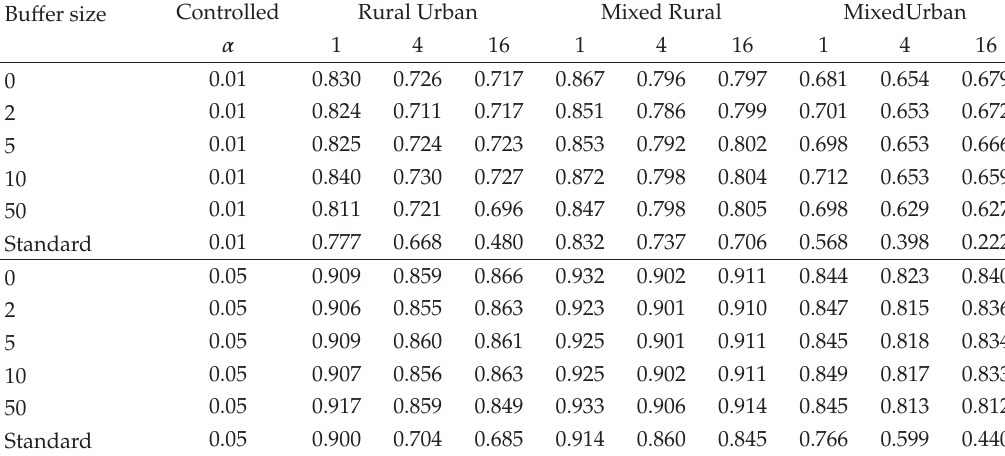
Table 4: Comparison of power to test the second most likely cluster for significance levels 0.01 and 0.05 when two true clusters exist and the tests are the bu ff er removing method and the standard scan statistic method. For the standard method, power is based on the critical values under the the null hypothesis that there are no true clusters. The upper 0.01 and 0.05 log likelihood ratio critical values are 9.717 and 7.907